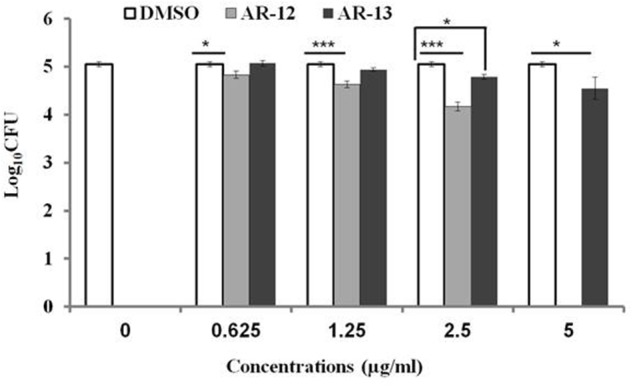
Intracellular growth of LVS in hMDMs following AR-13 treatment. hMDMs (MOI = 50) were infected for 2 h, washed and treated with different concentrations of AR-13 or its related compound AR-12, which was previously shown to inhibit Francisella via induction of autophagy. Intracellular bacterial CFUs were determined by plating cell lysates at 22 h post-infection. A negative control was media containing (0.05% v/v) DMSO. The experiment was repeated three times with hMDMs from three different donors with similar results and the data from a representative experiment are presented as average ± SD. ∗p ≤ 0.05, ∗∗∗p ≤ 0.001, NS, not significant.